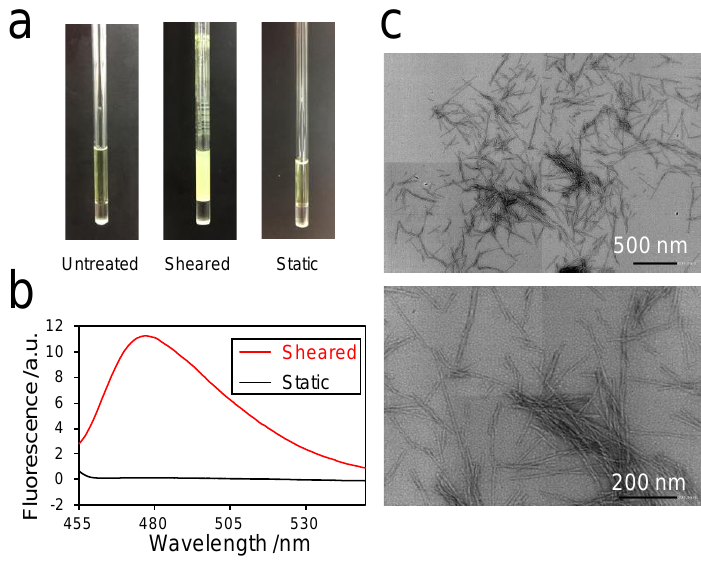
Figure 1. Superoxide dismutase 1 (SOD1) formed amyloid fibrils in the Rheo-NMR instrument: ( a ) Nuclear magnetic resonance (NMR) tubes containing the samples before ( left ) and after the Rheo-NMR measurements under sheared ( center ) and static conditions ( right ); ( b ) Thioflavin T (ThT) fluorescence spectra of sheared (red) and static (black) samples after the Rheo-NMR measurements for 48 h. a.u., arbitrary unit; ( c ) Transmission electron micrographs of SOD1 fibrils formed by shear flow. Scale bars, 500 nm ( upper panel) and 200 nm ( lower panel).